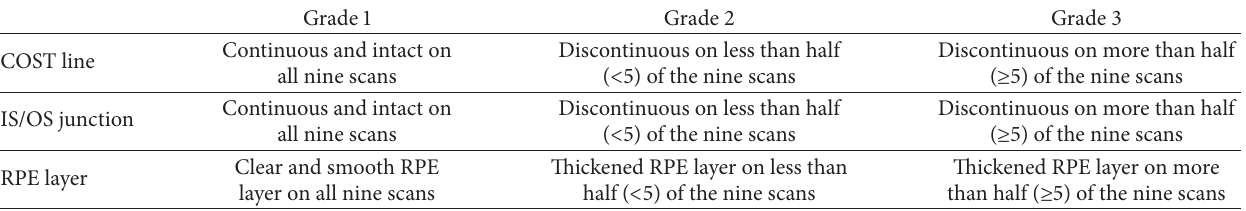
Table 1: Grading protocol for the COST line, IS/OS junction, and RPE layer thickness. Grade 1 Grade 2 Grade